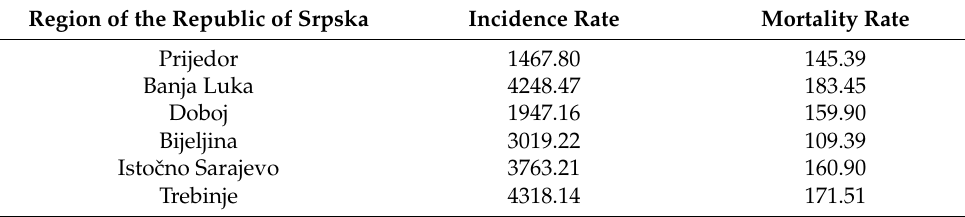
Table 4. Crude incidence and mortality rates of COVID-19 in 2020 in the RS. Region of the Republic of Srpska Incidence Rate Mortality Rate